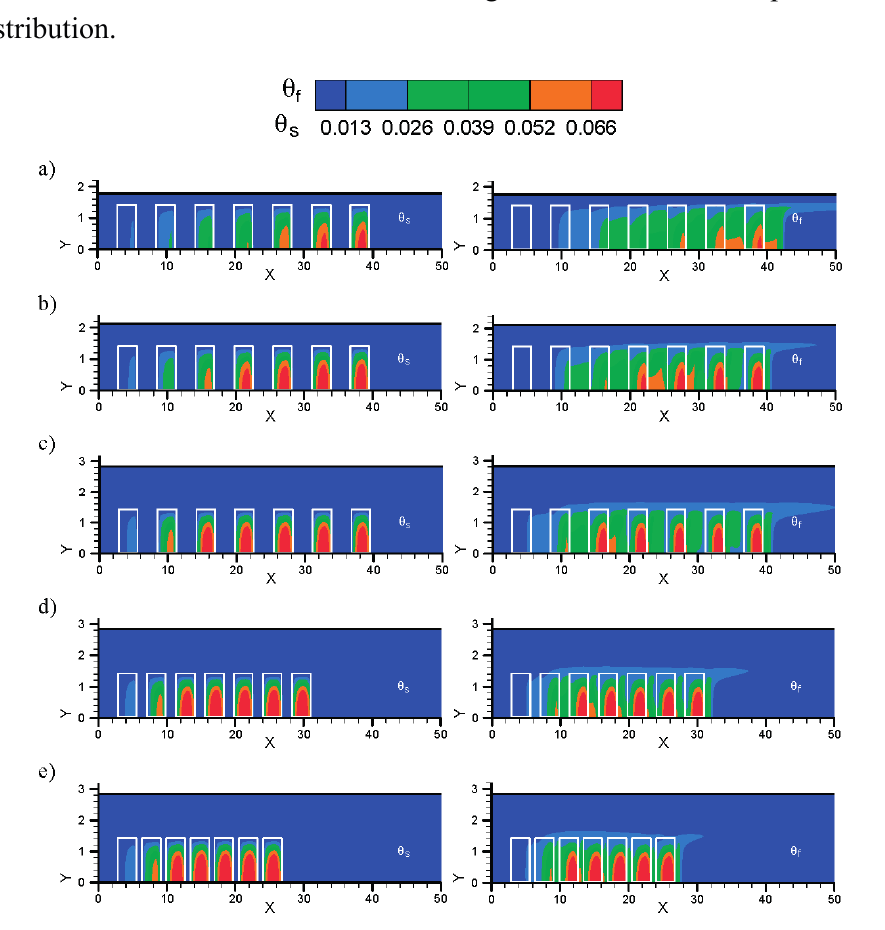
Figure 13. Dimensionless temperature contours for test Sample 1 with various values of X T * and X L * (the scales of X -axis and Y -axis are different): ( a ) X T * = 1.25; X L * = 2; ( b ) X T * = 1.5; X L * = 2; ( c ) X T * = 2; X L * = 2; ( d ) X T * = 2; X L * = 1.5; and ( e ) X T * = 2; X L * =